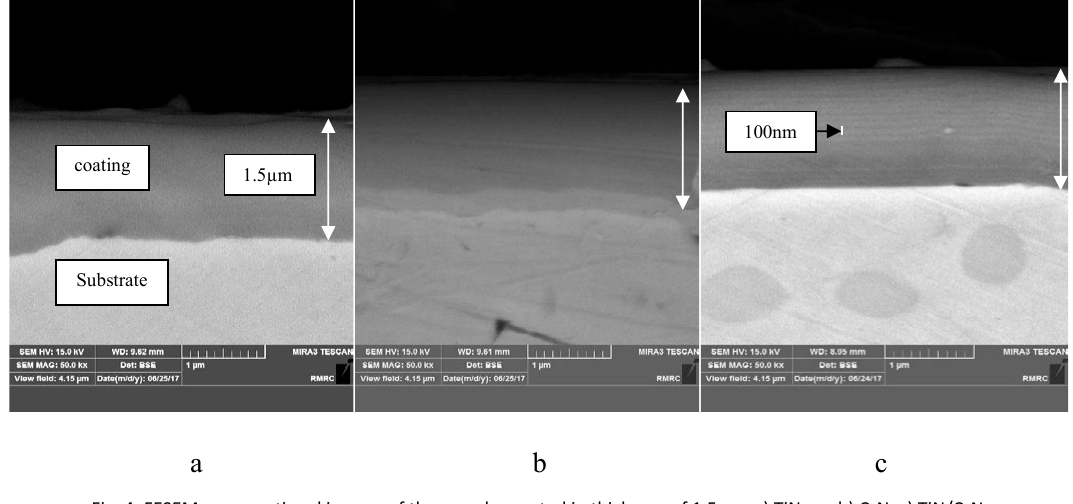
Fig. 4. FESEM cross sectional images of the samples coated in thickness of 1.5µm. a) TiN,